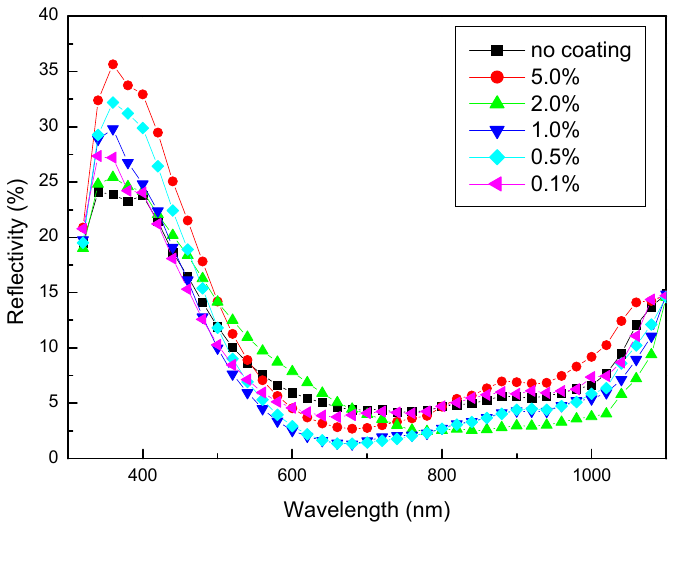
Figure 4. The reflectivity spectra for all the coated and non-coated solar cell samples in the wavelength range of 300–1100